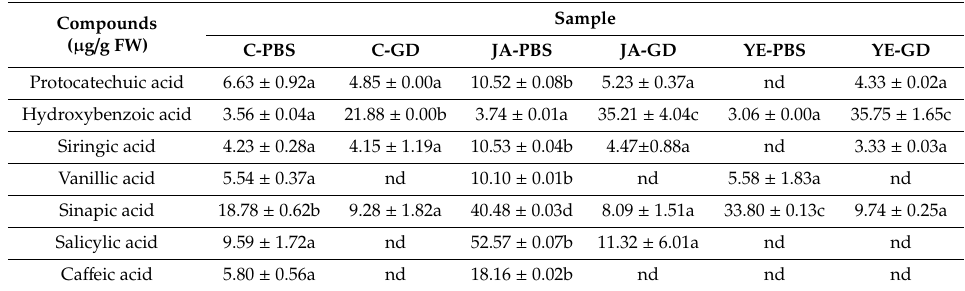
Table 1. Qualitative and quantitative analysis of the phenolic acids in the control, elicited lovage bu ff er (PBS (phosphate bu ff ered saline)) extracts, and gastrointestinally digested (GD) extracts. C-PBS—PBS extracts from the control plants; JA-PBS—PBS extracts from the plants elicited with the solution of 10 µ M jasmonic acid; YE-PBS—PBS extracts from the plants elicited with the 0.1% yeast extract: C-GD—gastrointestinally digested extracts from the control plants; JA-GD—gastrointestinally digested extracts from the plants elicited with the solution of 10 µ M jasmonic acid; YE-GD—gastrointestinally digested extracts from the plants elicited with the 0.1% yeast extract; nd—not detected. Values in the rows designated by the di ff erent letters are significantly di ff erent ( p < 0.05). Compounds ( µ g / g